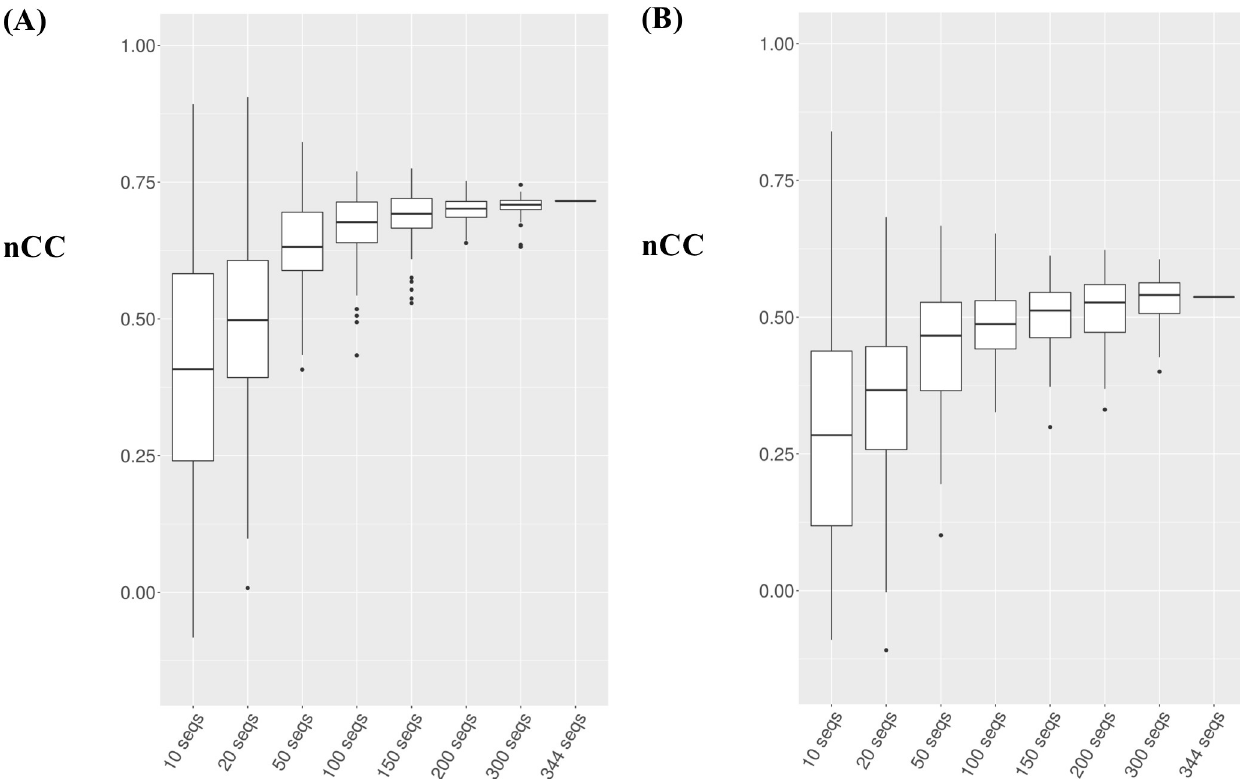
Fig 6. The performance of DIpartite: (A) PWM; (B) DWM. 100 datasets were generated by sampling of the σ A dataset. The sizes of the dataset were 10, 20, 50, 100, 150, 200, 300 sequences.